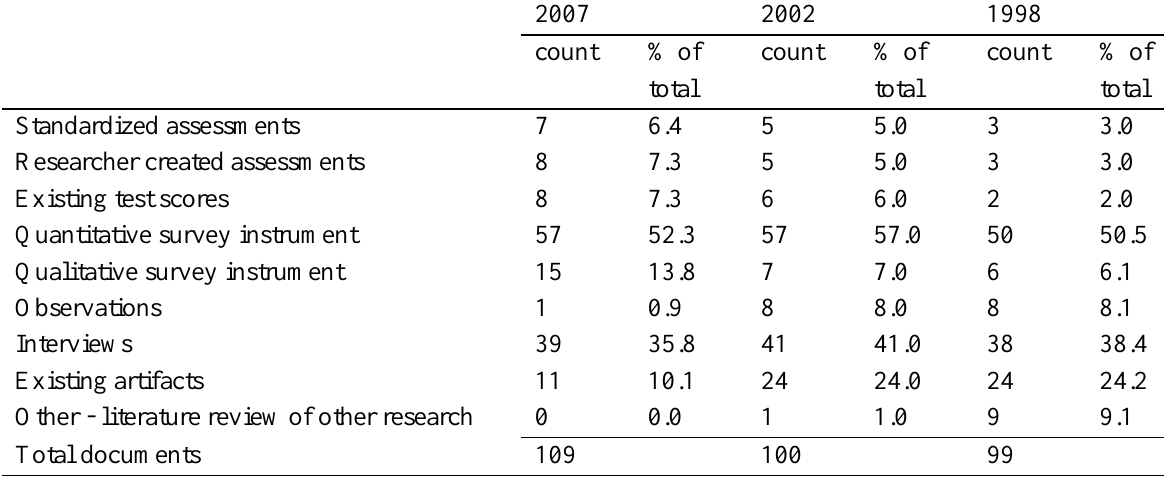
Table 5 Data Collection Methods Distribution by Year